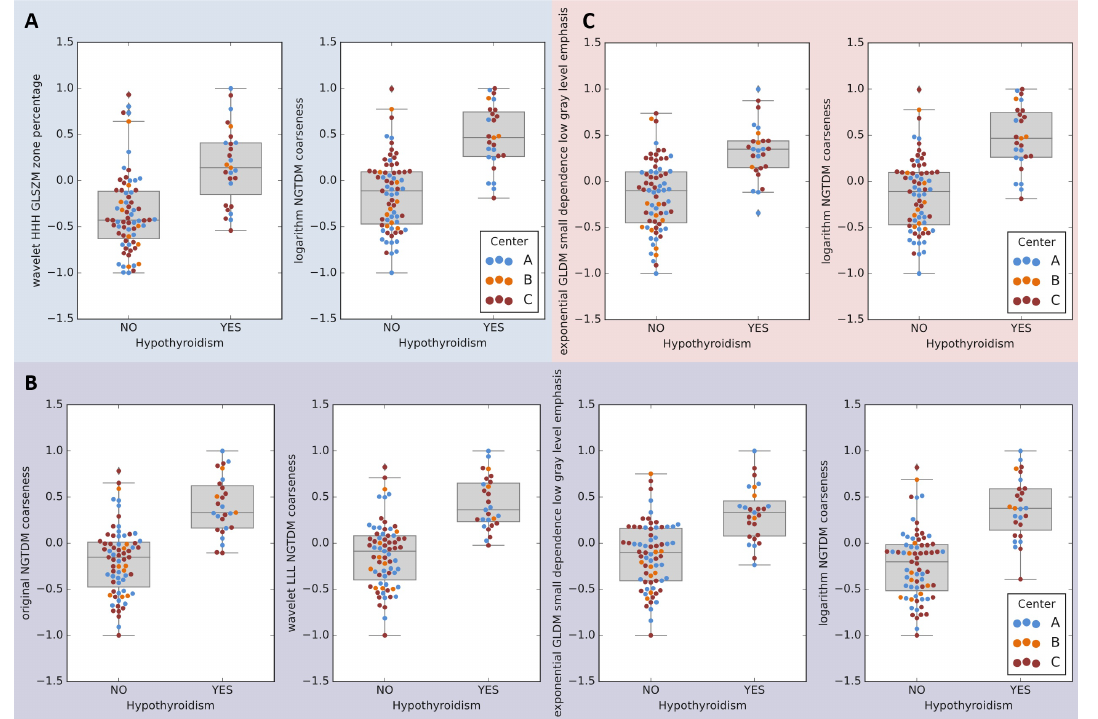
Figure 6. Transformed (normalized and scaled) values of features retained in radiomic models. A : variant Ia, B : variant: Ib, C : variant